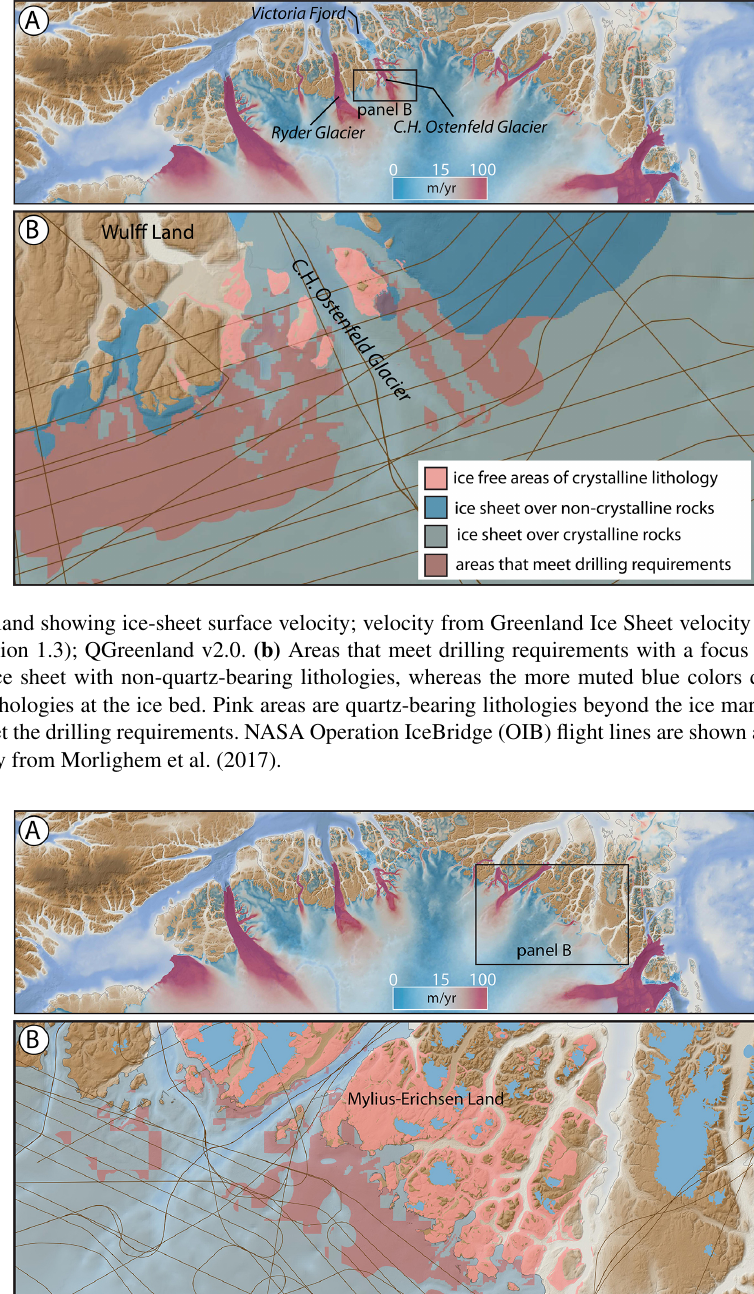
The Cryosphere, 16, 3933–3948, 2022